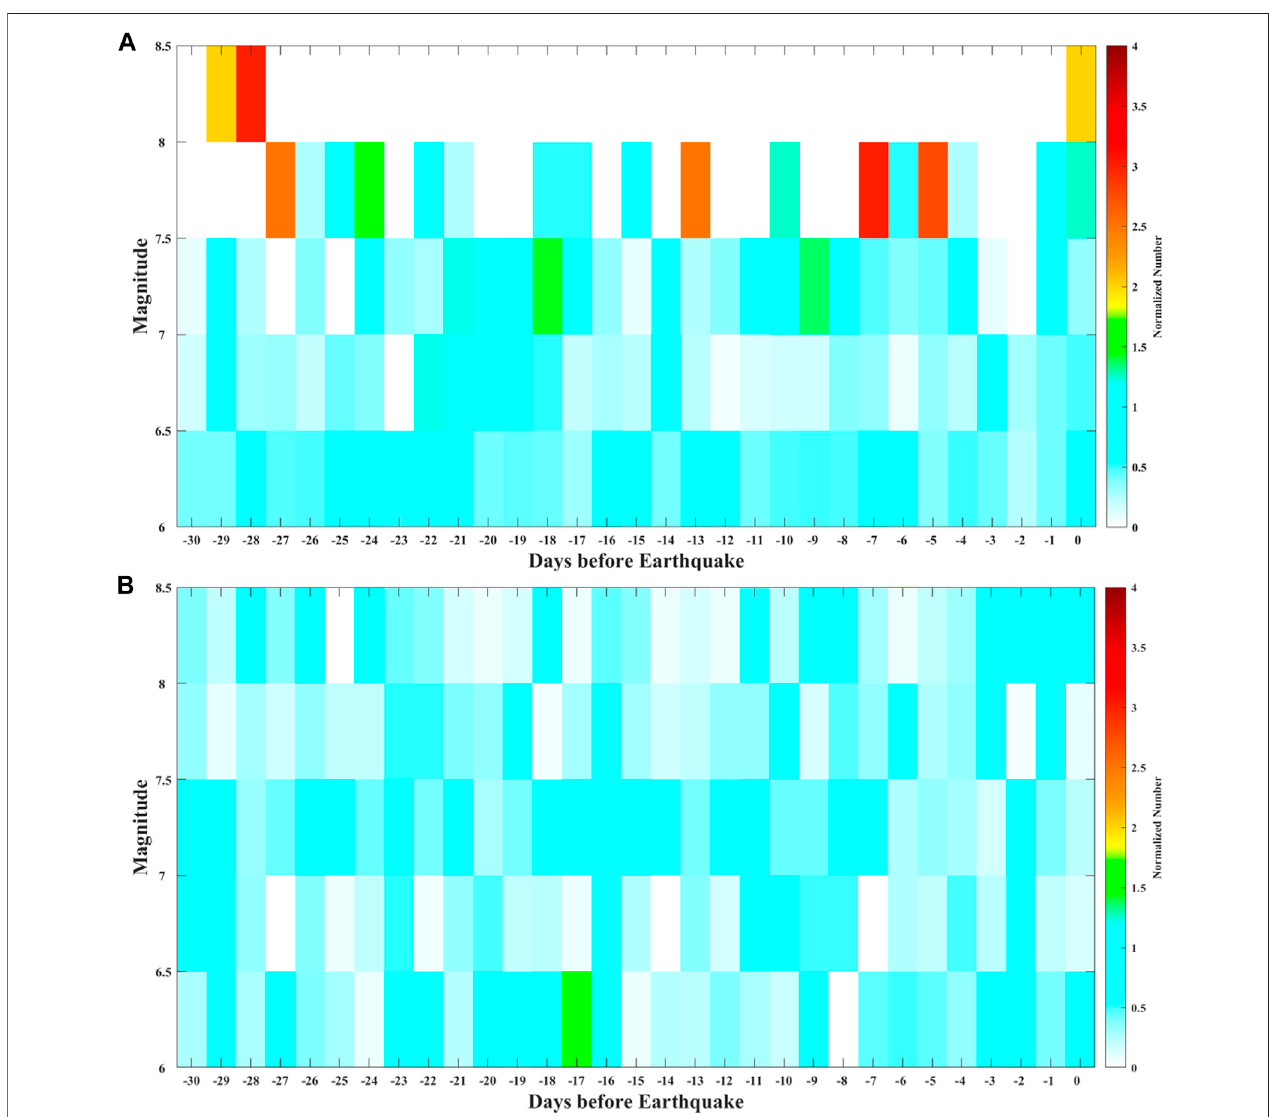
FIGURE 11 | Statistical result of seismo-ionospheric disturbances with the days before earthquakes ( X -axis) and seismic magnitude ( Y -axis) by SESA. (A,B) Statistical results of real and random earthquakes, respectively. The color represents the normalized number by SESA, which is illustrated in the text.